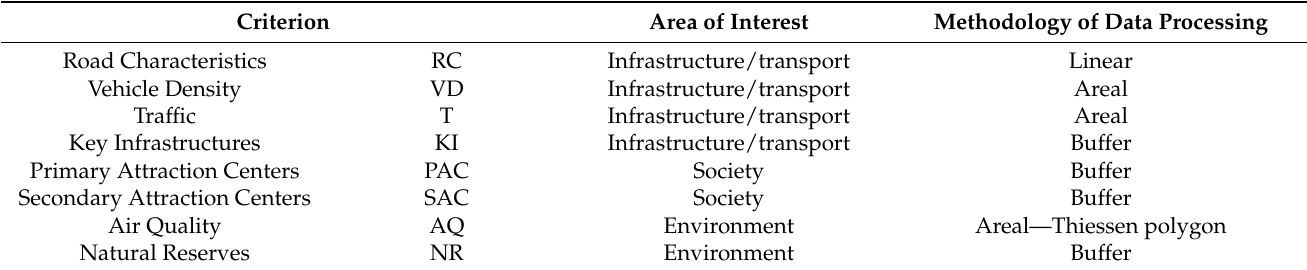
Table 1. Criteria definition and